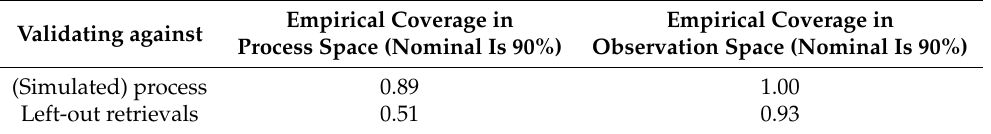
Table 1. Coverage diagnostics when validating against the ‘true’ (simulated) process values and the left-out retrievals using prediction intervals constructed in (i) process space and (ii) observation space. The nominal coverage is 90%, obtained by assuming that the prediction standard errors are